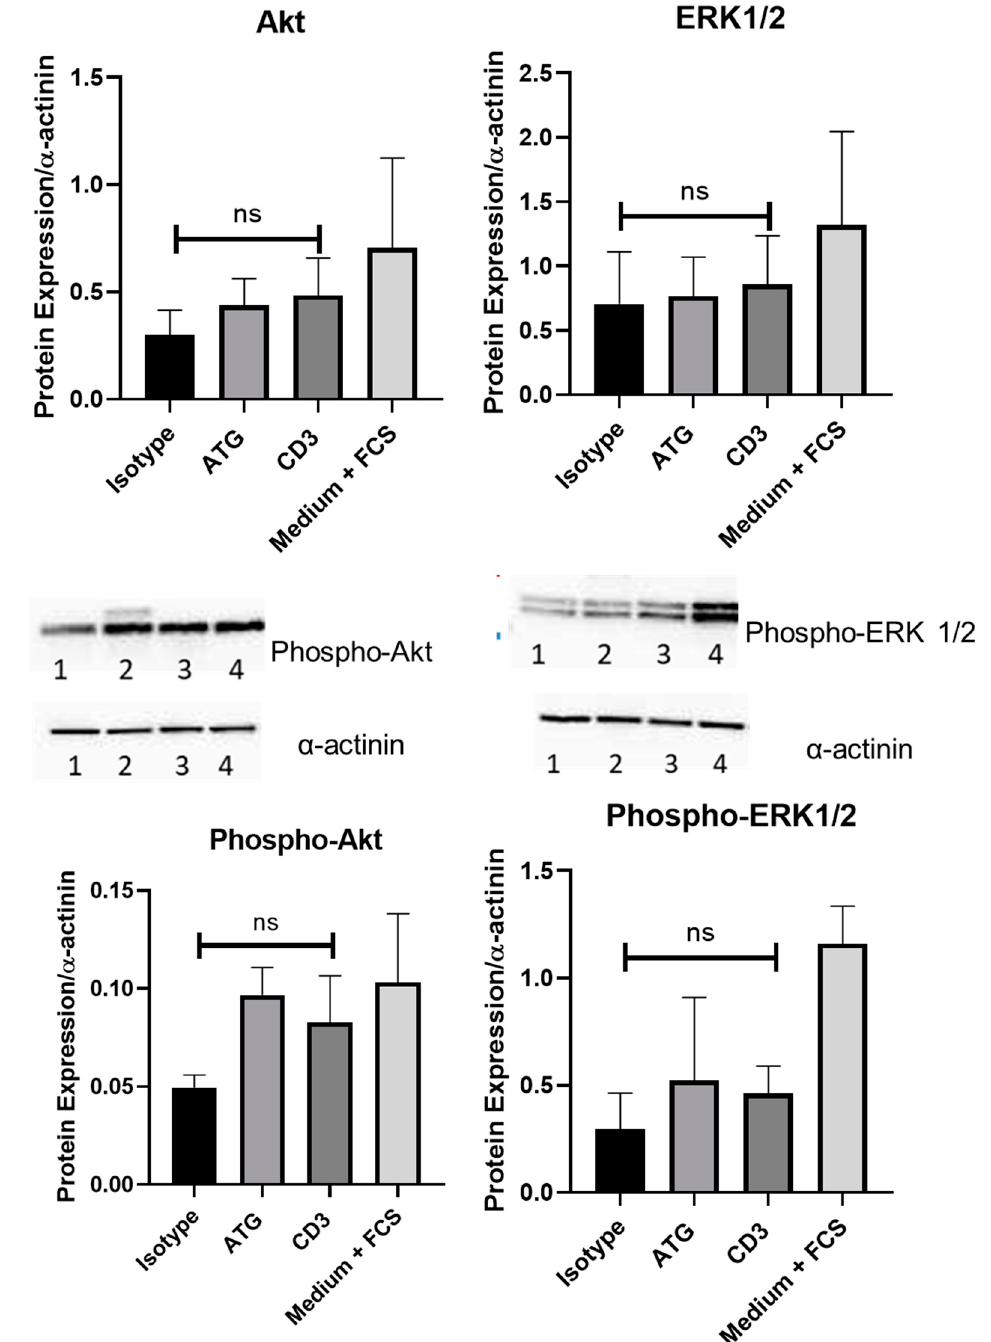
Figure 4. The effect of anti-CD3 treatment on intracellular pathways was investigated by Western Immunoblotting. In human cardiomyocytes, co-incubation with supernatant of PBMCs treated with anti-CD3 antibody did not alter phosphorylation of Akt (0.05 ± 0.01 versus 0.08 ± 0.02 protein expression/alpha-actinin; p = n.s.) and ERK1/2(0.30 ± 0.17 versus 0.46 ± 0.13 protein expression/alpha-actinin; p = n.s) compared to isotype control. Representative pictures of the isotype (1), ATG (2), anti-CD3 (3) and medium plus FCS (4) conditions are shown.